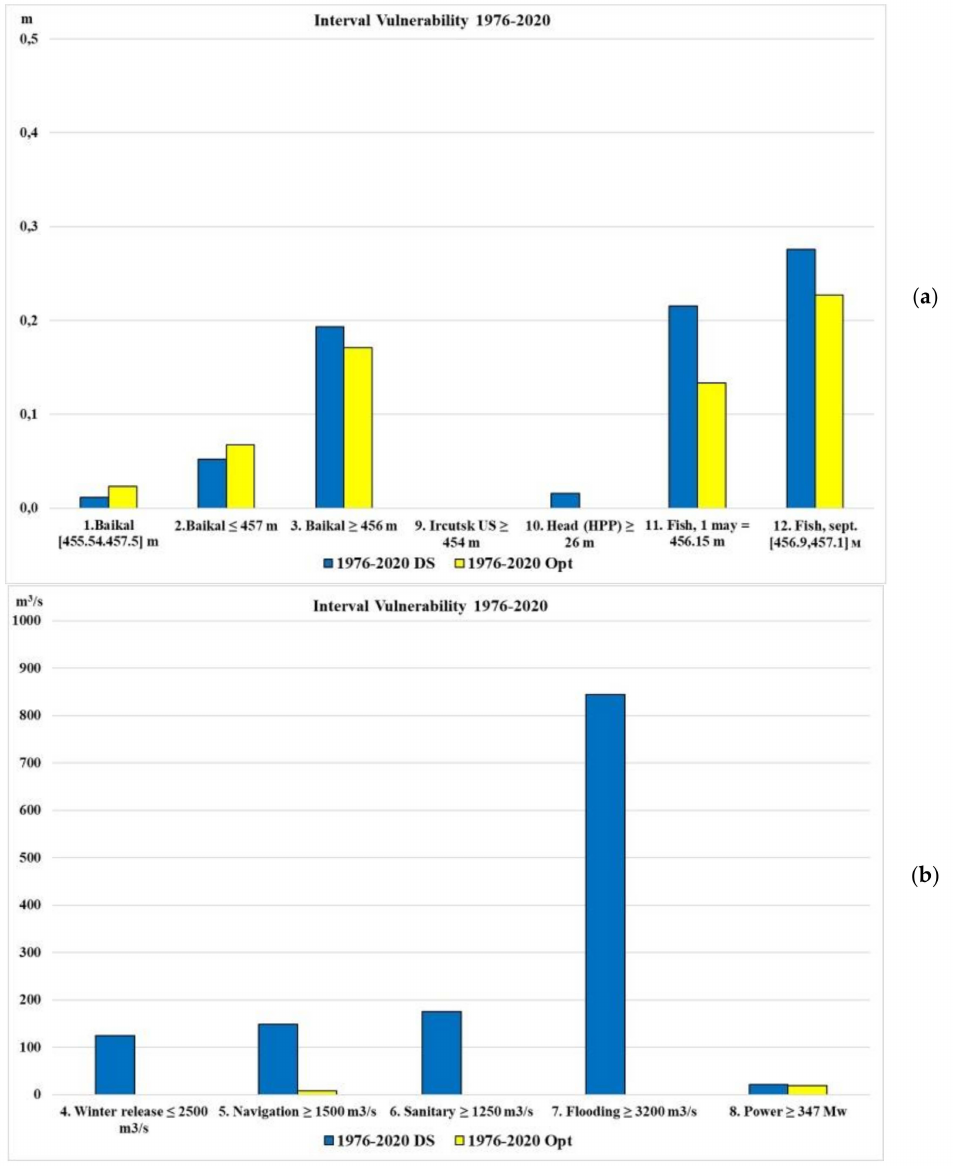
Figure 20. Interval vulnerability when WRC use DS and optimization (series 1976–2020) for criteria 1, 2, 3, 9, 10, 11, 12 ( a ) for criteria 4, 5, 6, 7, 8, ( b